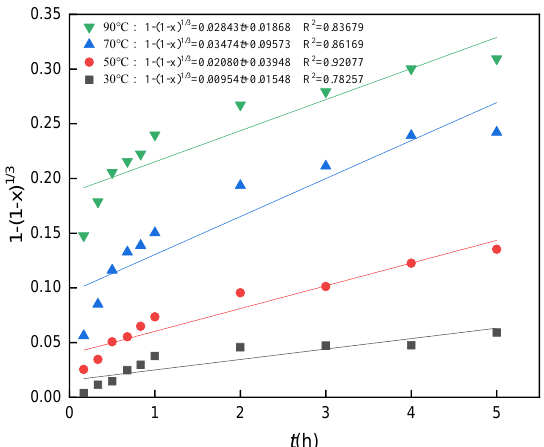
Figure 14. Relationships between 1 − 2/3x − (1 − x) 2/3 and time of aluminum ions.